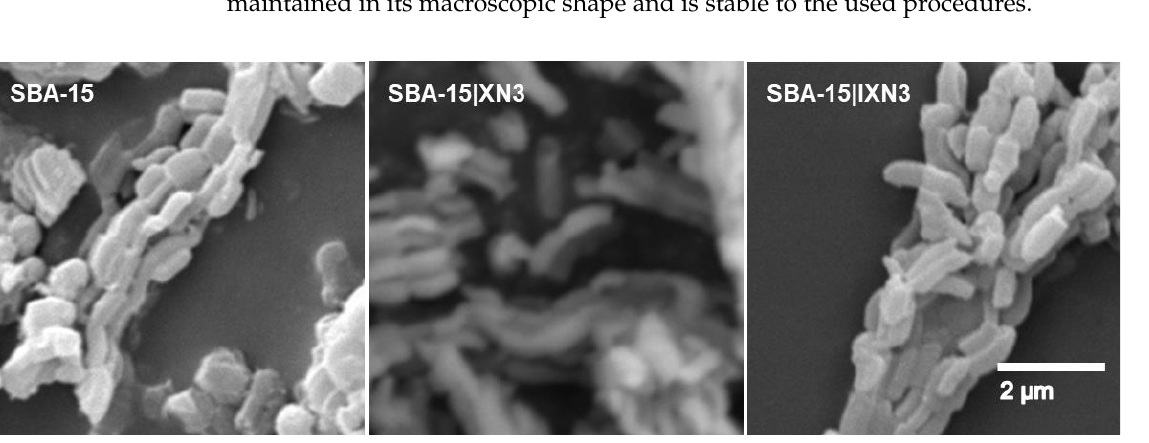
Figure 2. SEM images of SBA-15, SBA-15|XN3 and SBA-15|IXN3, as example.